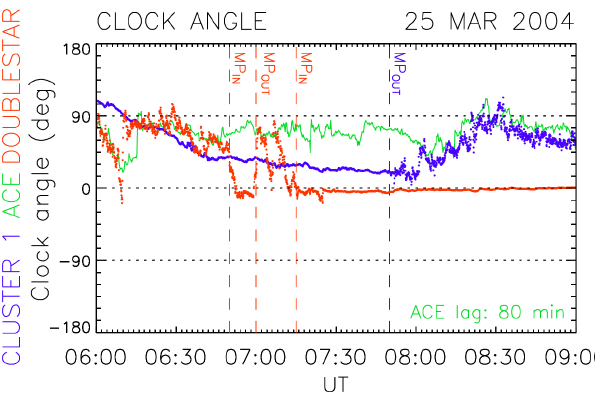
Fig. 2. A comparison of the magnetic field clock angle observed at ACE, Cluster 1, and TC-1 between 06:00–09:00 UT. Cluster 1 and TC-1 magnetopause crossings discussed in the text are indicated by appropriately coloured dashed